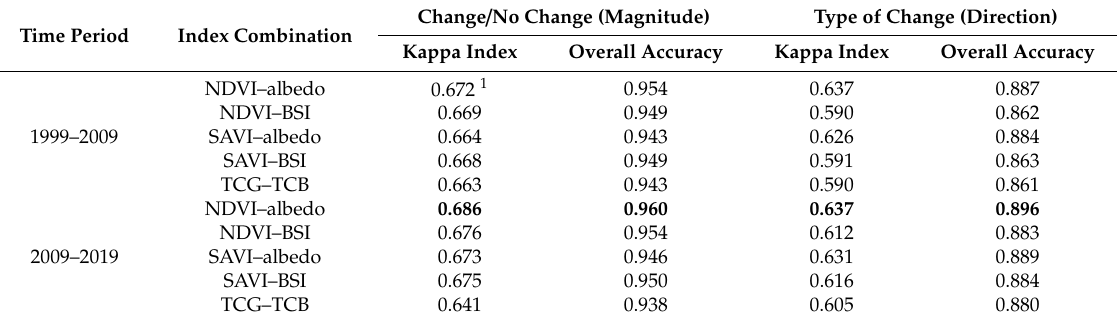
1 Bold style indicates the highest